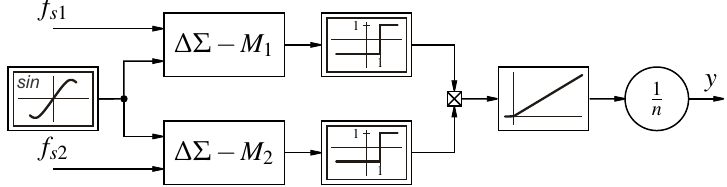
Figure 12. Testbench for evaluating the independence of the noise from ∆Σ